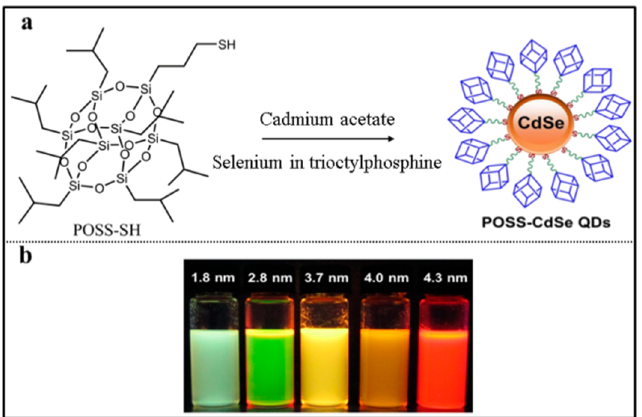
Figure 7. ( a ) Synthetic procedure of POSS-CdSe QDs [80]. ( b ) The photoluminescence color change of the POSS-CdSe QDs under a UV lamp during the growth [80].